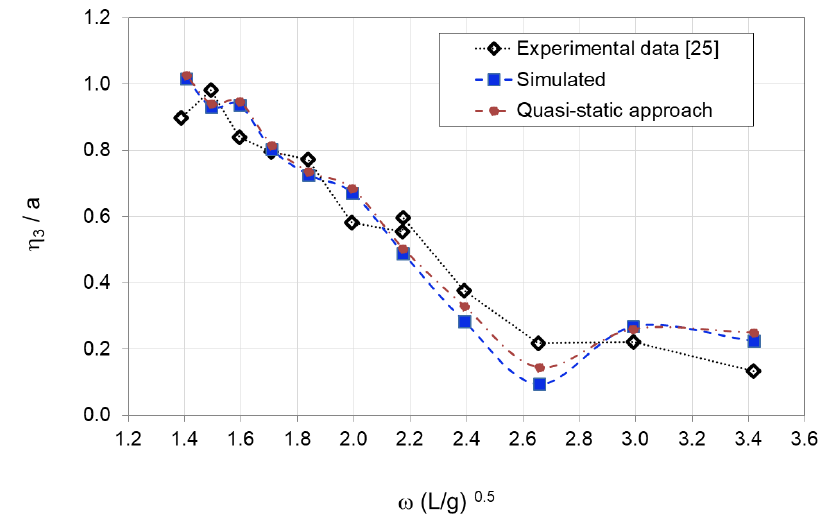
Figure 12. Pitch RAO in head sea: comparisons between simulated and experimental data.